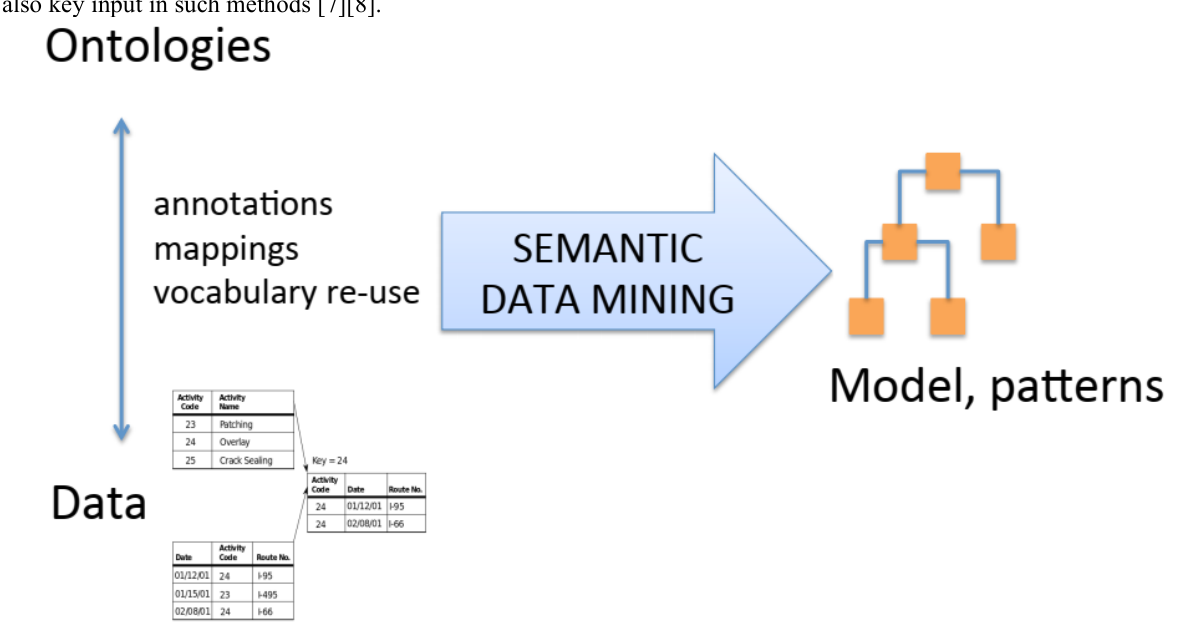
Figure 2. Ontology in semantic web data